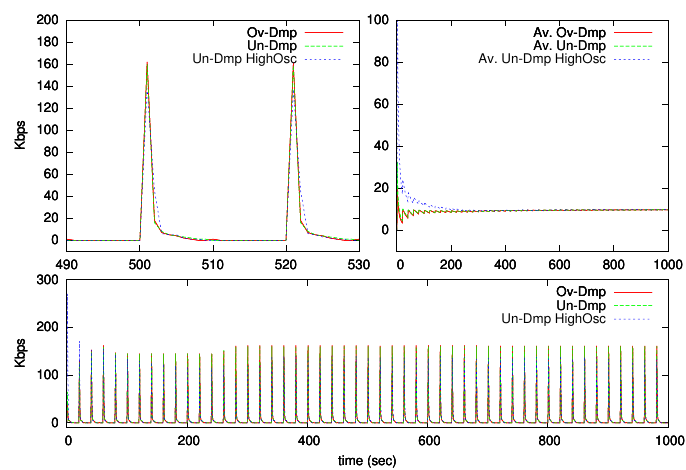
Figure 6. Throughput behavior for the three signals in Kbps.